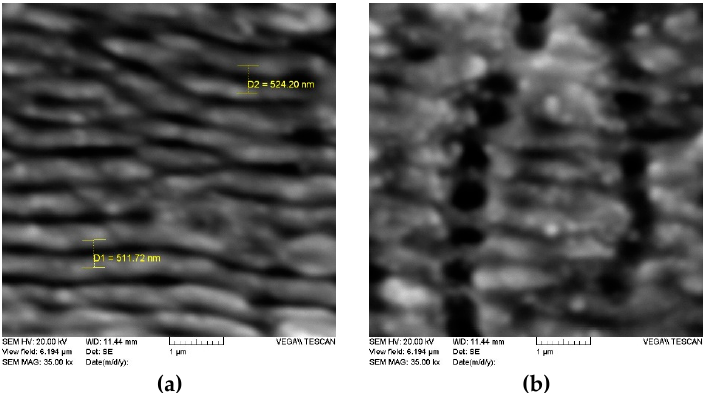
Figure 4. SEM images: ( a ) nano LIPSS and ( b ) self-organized hierarchical structures of micro/LIPSS in the groove.